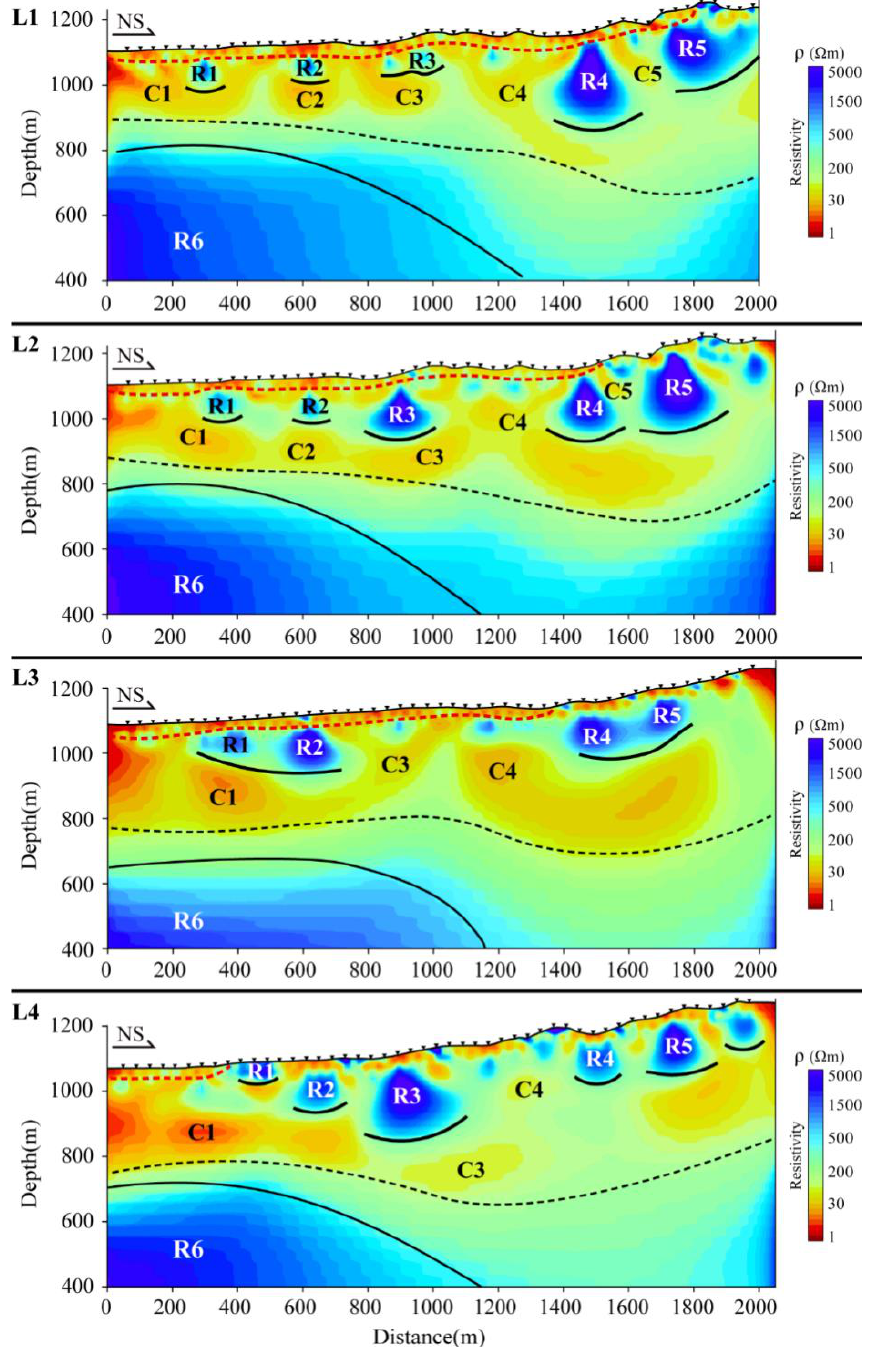
Figure 3. The 2D inversion models of the four profiles in this research. R1, R2, R3, R4, R5, and R6 refer to high-resistivity blocks with different scales and embedded depths. The same high-resistivity block has different shapes in different profiles, which represents the lateral changes of the high-resistivity block. For example, R3 is obvious in sections L2 and L4, but indistinctive in profiles L1 and L3, while R5 is obvious in profiles L1 and L2, but inapparent in profiles L3 and L4. C1, C2, C3, C4, and C5 refer to low-resistivity blocks with various scales and embedded depths. The short solid lines beneath the high-resistivity blocks represent the boundary between high resistivity and low resistivity.